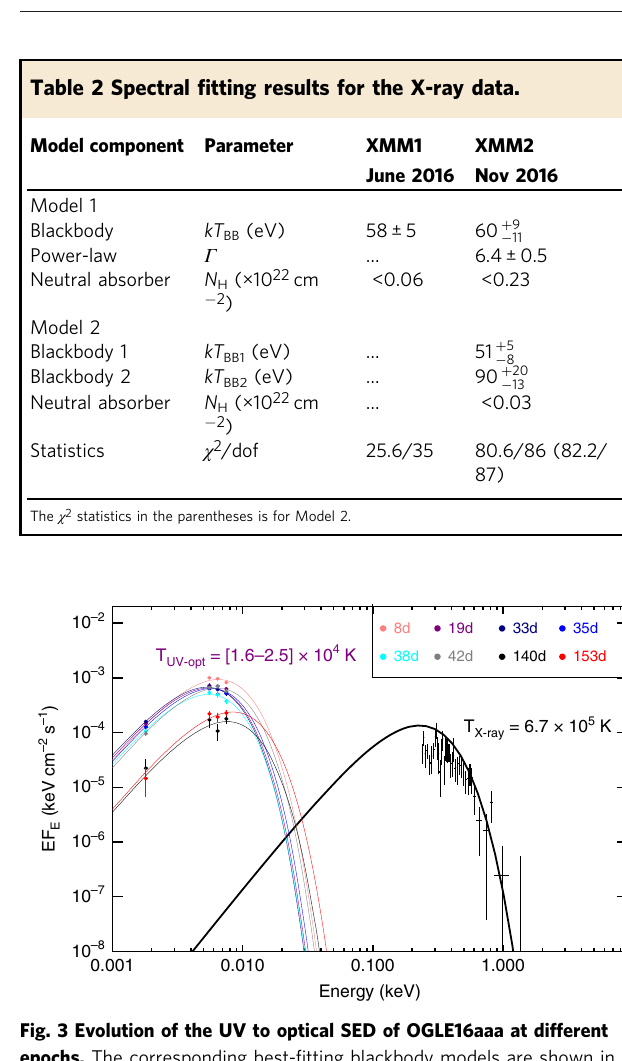
Fig. 2 Fittings to the X-ray spectra of OGLE16aaa from XMM-Newton observations at two epochs. a XMM-Newton PN spectra for OGLE16aaa along with the best- fi tted single blackbody model. Error bars represent 1 σ uncertainties calculated using Poisson statistics. The data observed on 9 June 2016 (XMM1) are shown in red, whereas that obtained on 30 November 2016 (XMM2) shown in black. The corresponding data to model radios are shown in b . c The joint 68%, 90%, and 99% con fi dence contours of the blackbody temperature vs. luminosity for the two observations. The vertical dotted lines represent the best- fi tted temperatures. d The best- fi tting result by including an additional blackbody component to account for the excess emission at above ~0.7 keV for the XMM2 data, which is shown in dashed line, and e is the corresponding data/model ratio. f The same as e , but for the data/model ratio from spectral fi tting by using an additional power-law component to describe the excess emission.